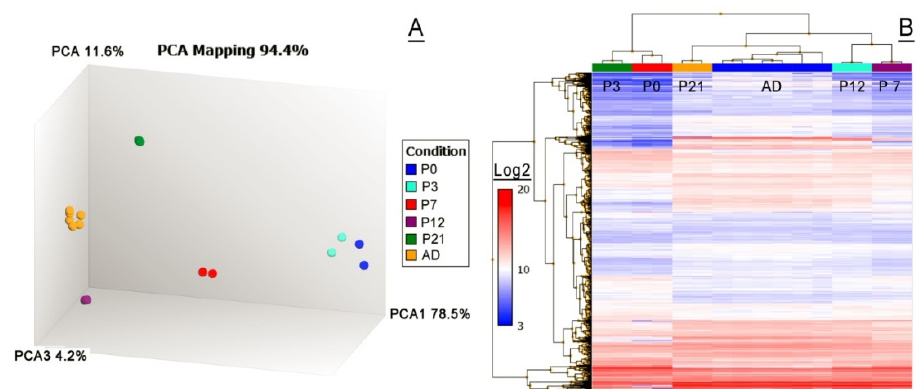
Figure 8. An unbiased transcriptomic analysis of mouse tarsal plates (TPs) using the Principal Component Analysis approach. ( A ) A PCA map of the 1000 most highly expressed genes analyzed using mRNA microarrays. Note a very tight grouping of the samples older than P3. The P0 and P3 samples show a slightly looser grouping due to faster changes in their transcriptomes and the possible impact of a 12 to 24 h uncertainty in the actual time of birth of the mouse pups. ( B ) A hierarchical clustering diagram and a heat map of about 5000 highly expressed genes (on a Log2 scale).